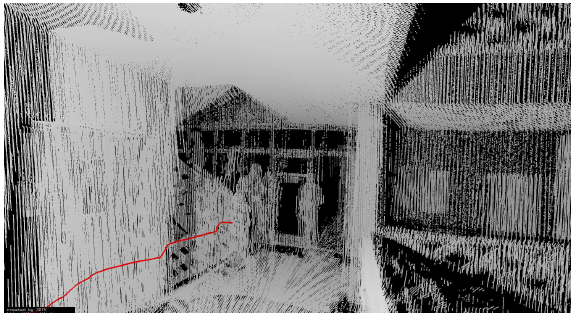
Figure 9. People walking through the scene, while scanning was in